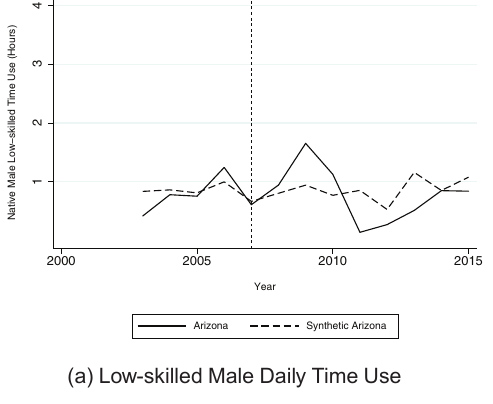
Native low-skilled male daily time spent on housework, gardening, and caring for